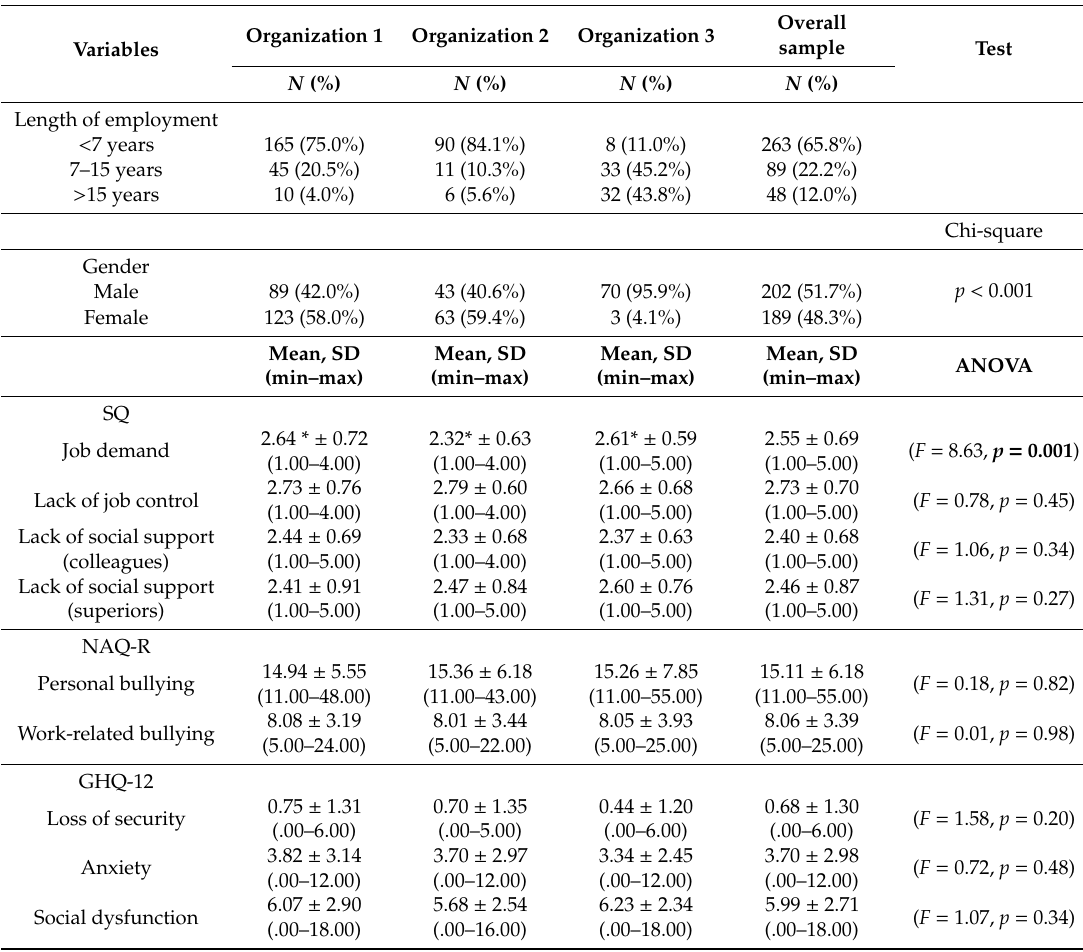
Table 1. Characteristics of the study population and results of stress questionnaire (SQ), Negative Acts Questionnaire Revised (NAQ-R) and General Health Questionnaire (GHQ-12) stratified by organization and comparisons between